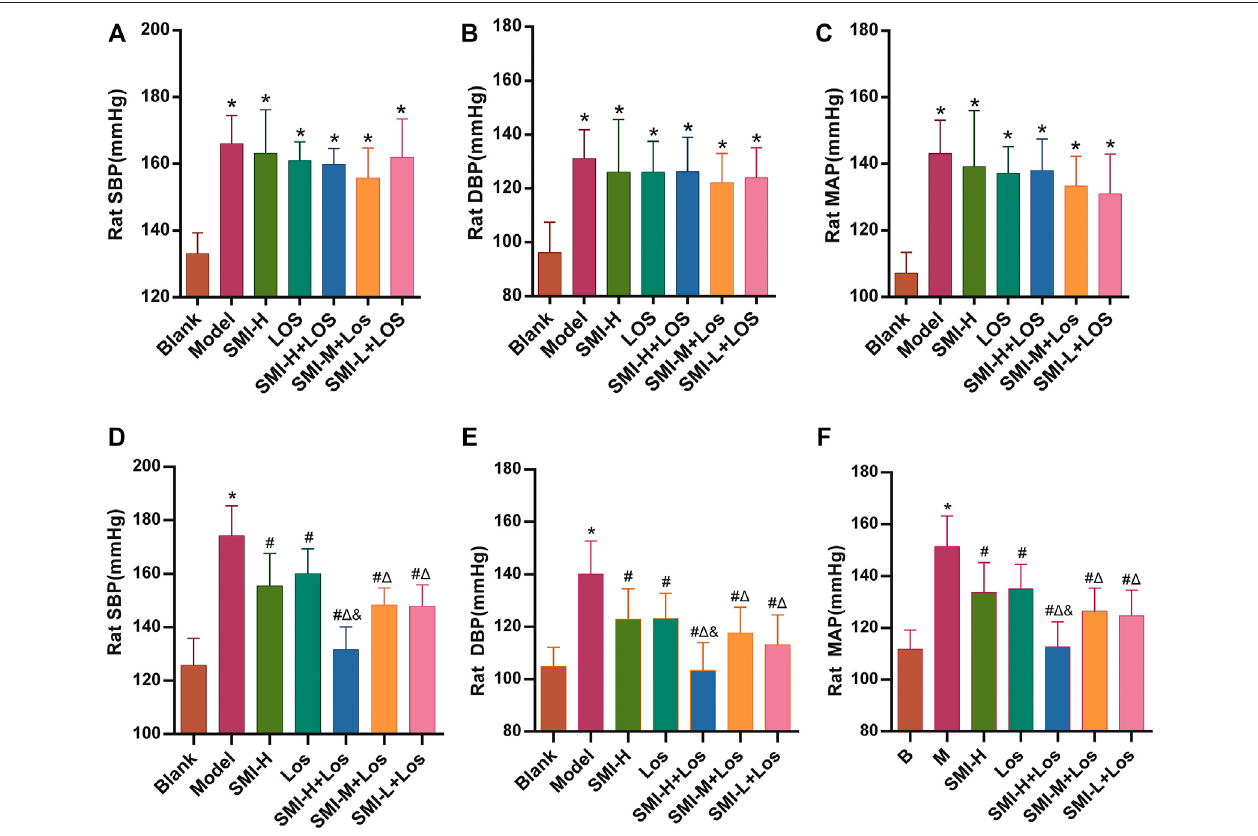
FIGURE 1 | The SBP, DBP and MAP of each group were shown after 4 weeks (A – C) and 6 weeks (D – F) treatment. * indicates p < 0.05 compared with the Blank group.#indicates p < 0.05comparedwiththemodelgroup; Δ indicates p < 0.05comparedwiththeLOSgroup;andindicates p < 0.05comparedwiththeSMI-M+LOS andSMI-L+LOSgroup.ModelgroupwastreatedwithL-NAME60 mg/kg · d-1intragastrically;theSMIhigh-dosegroup(SMI-Hgroup)receivedSMI6 ml/kg/dintailvein injection; LOS group was given LOS 10 mg kg − 1 . d − 1 intragastrically; LOS plus SMI high-dose group (SMI-H + LOS group), LOS plus SMI medium-dose group (SMI-M + LOS group) and LOS plus SMI low-dose group (SMI-L + LOS group) were respectively given SMI 6 ml kg − 1 . d − 1 , 4 ml kg − 1 . d − 1 and 2 ml kg − 1 . d − 1 in tail vein injection, based on LOS 10 mg kg − 1 . d − 1 intragastrically. SBP, systolic blood pressure; DBP, diastolic blood pressure; MAP, mean arterial pressure; L-NAME, N (omega)-nitro-L-arginine methyl ester.